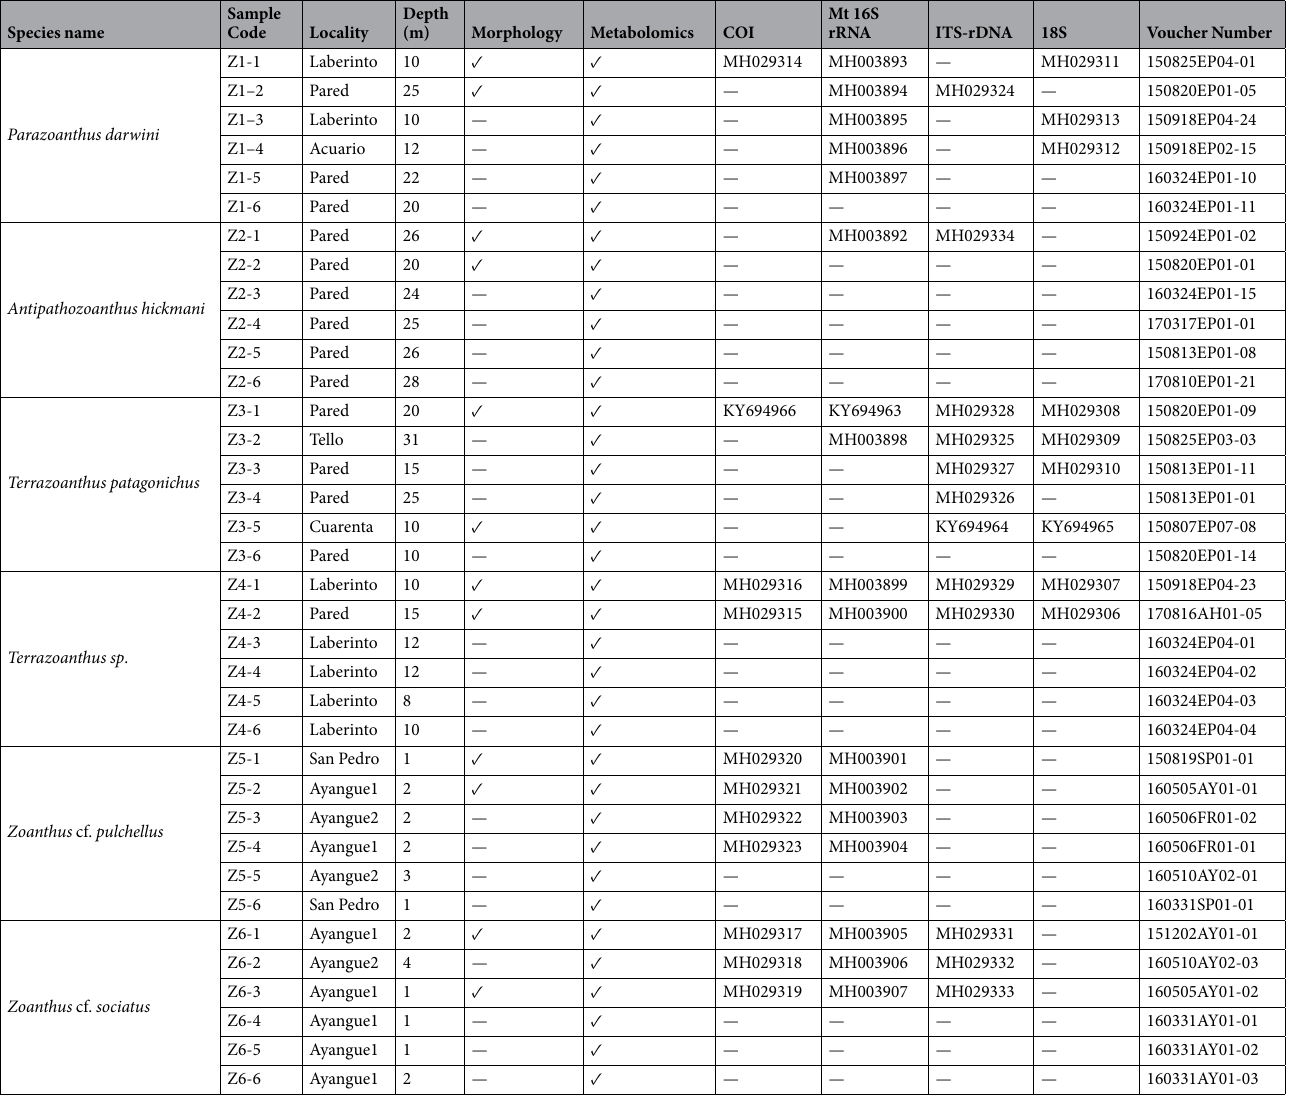
Table 2. Species, specimens, localities, voucher numbers and GenBank accession numbers analyzed in this